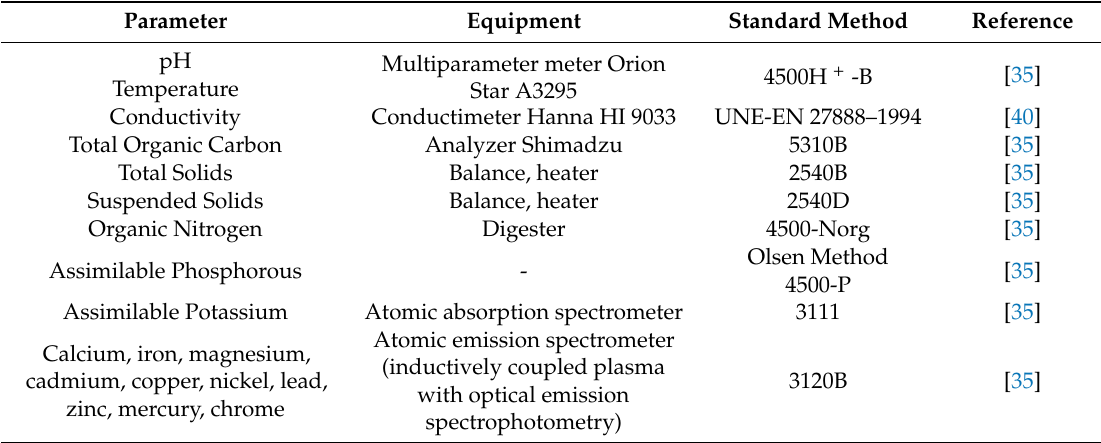
Table 3. Physico-chemical parameters, equipment and standard methods.